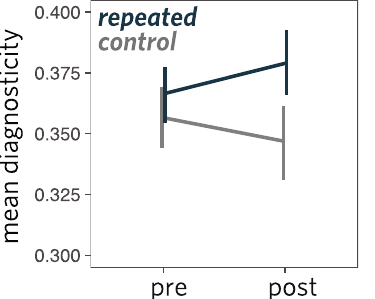
Fig. 7 | Results for diagnosticity analysis. Changes in the mean diagnosticity of drawn parts is shown from the pre to post. Error bars represent bootstrapped 95% con fi dence intervals.